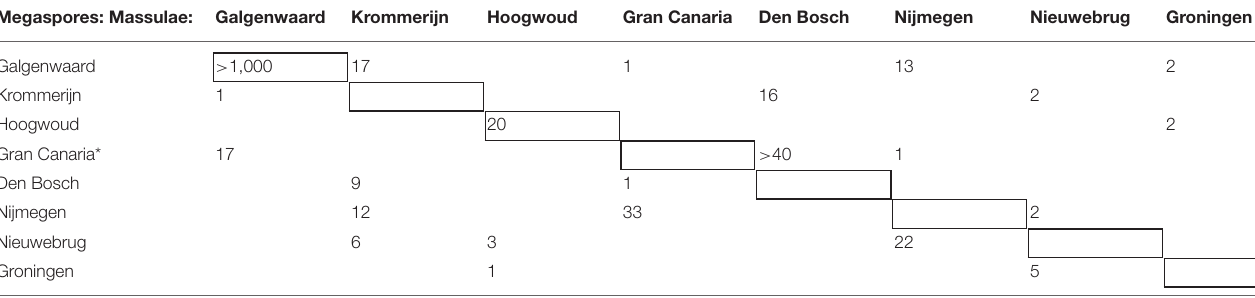
TABLE 1 | Sporeling counts obtained from the random crosses of Azolla filiculoides strains collected in the Netherlands and Spain (Gran Canaria). Megaspores: Massulae: